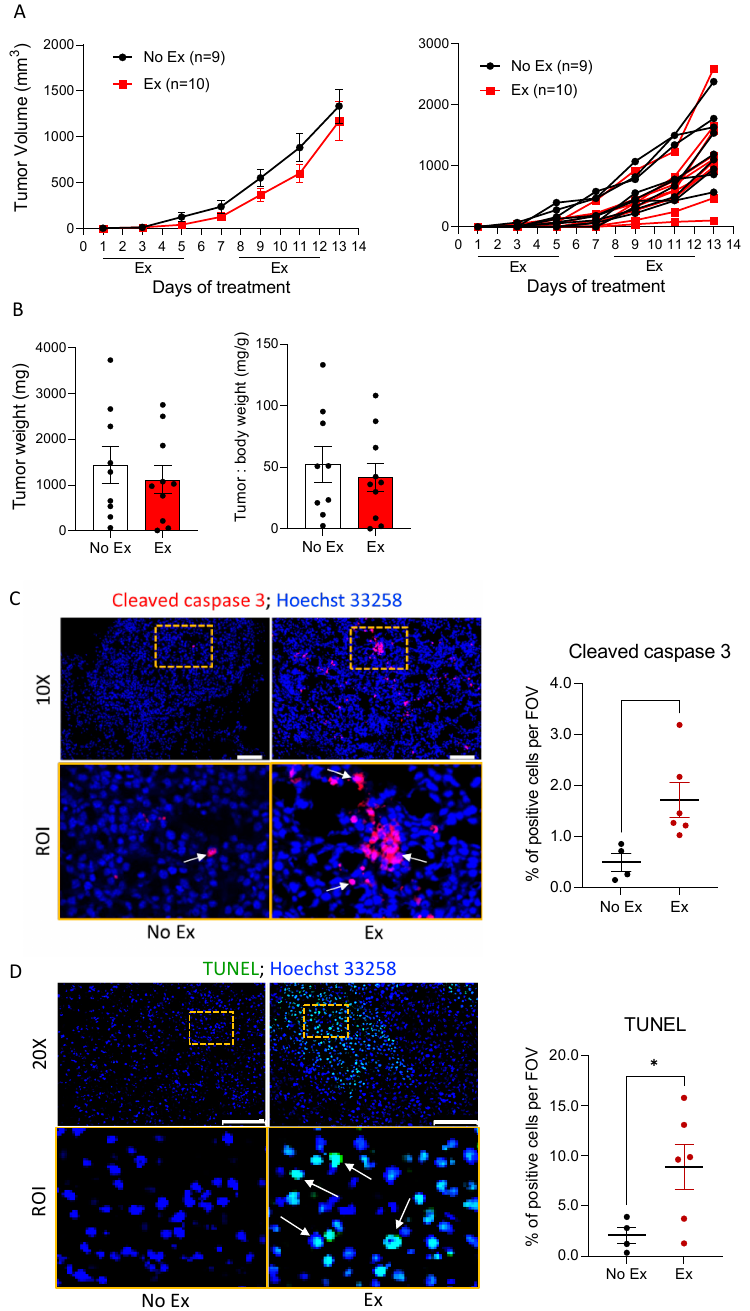
Figure 3. Exercise promotes apoptosis in B16F10 tumors. ( A ) B16F10 tumor volumes were measured by caliper over time in No Ex and Ex mice, and are displayed as the group mean ± SEM and as individual tumors. ( B ) Final tumor weight and the ratio of tumor to body weight were assessed. Black dots indicate an individual value of tumor weight or tumor: body weight. ( C , D ) Representative immunofluorescent images of cleaved caspase-3 and TUNEL staining ( upper panels ) were obtained using 10 × and 20 × objective lenses, respectively. Scale bars = 100 µ m. ROI (region of interest) selected from a specific area (dotted yellow box) of 10 × or 20 × magnification, image-defined patterns of signals to cleaved caspase-3 and DNA fragmentation ( lower panels ). The number of nuclei (Hoechst 33258, blue) and cleaved caspase-3 (red)- or TUNEL (green)-positive cells were counted. Graphs show quantification of the values of co-localized signal on the nucleus in three to eight images of each sample. Black and red dots indicate an individual value in No Ex and Ex, respectively. Data are shown as mean ± SEM. * p < 0.05 vs. No Ex.